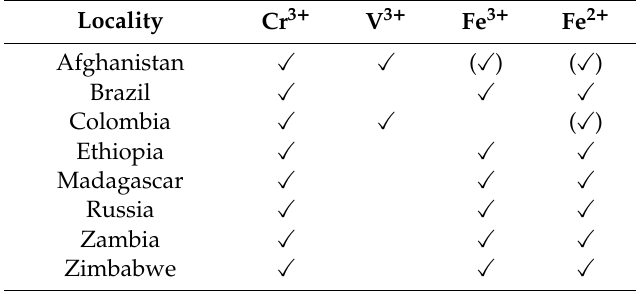
Figure 13. UV-Vis polarized spectra of an emerald from Colombia. The light blue and orange lines are for the o-ray and e-ray spectra, respectively. The upper spectrum has been vertically offset for clarity.